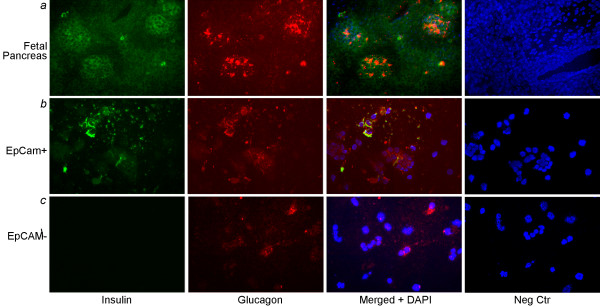
Endocrine phenotype of EpCAM-positive fetal pancreatic cells. (a) shows immunostaining of 22-week fetal human pancreas to demonstrate cells in primitive pancreatic islets with coexpression of insulin and glucagon. Negative controls, where primary antibodies were omitted, are on extreme right. (b) shows isolated freshly EpCAM-positive cells with coexpression of insulin and glucagon in some cells. (c) shows EpCAM-negative fraction showing occasional cells with glucagon. Orig. mag., a, ×200; b and c, ×400.